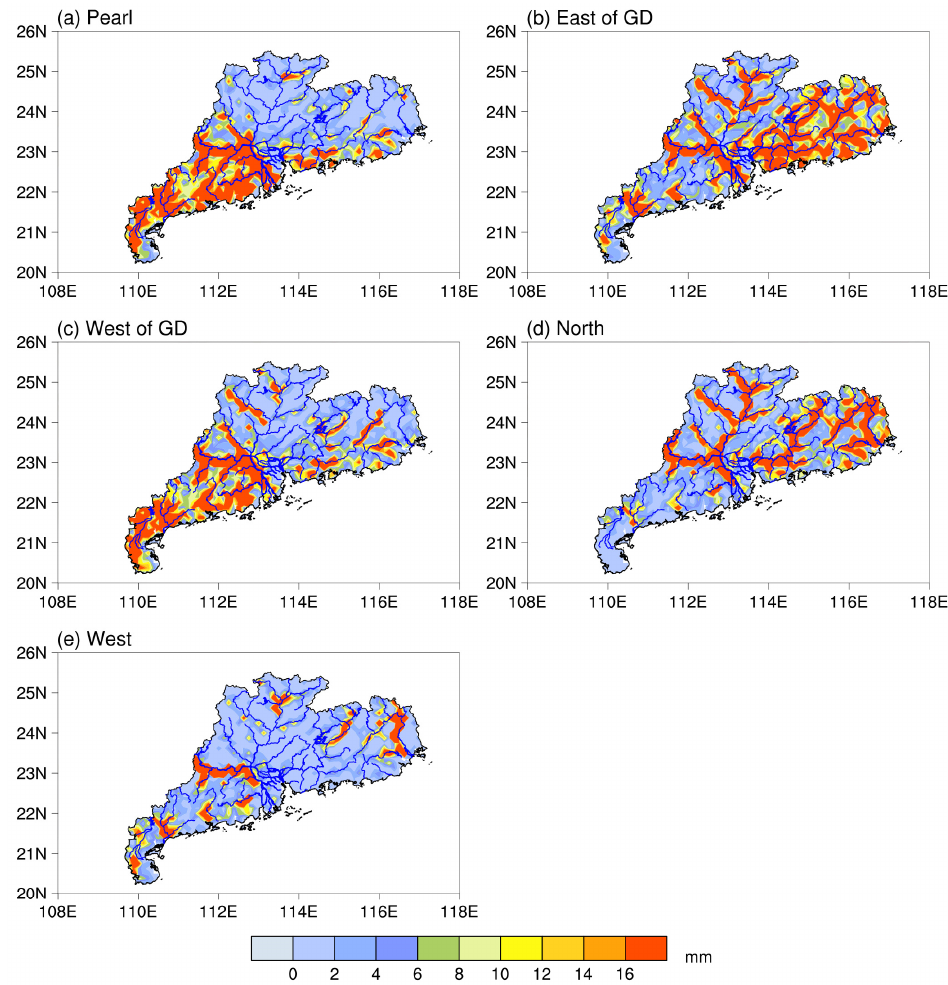
Figure 6. The same as Figure 4, but for the flood